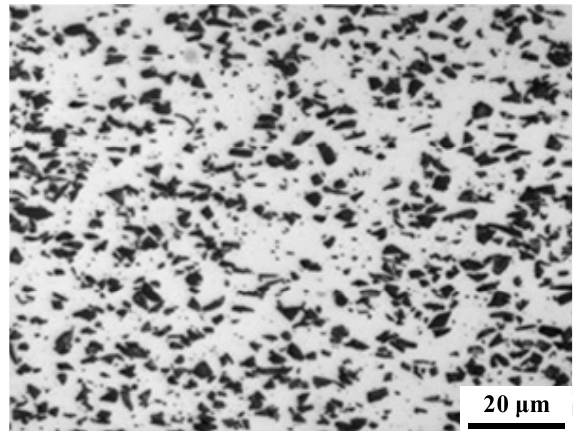
Figure 2. Microstructure of 17vol.% SiC p /2009Al composites.